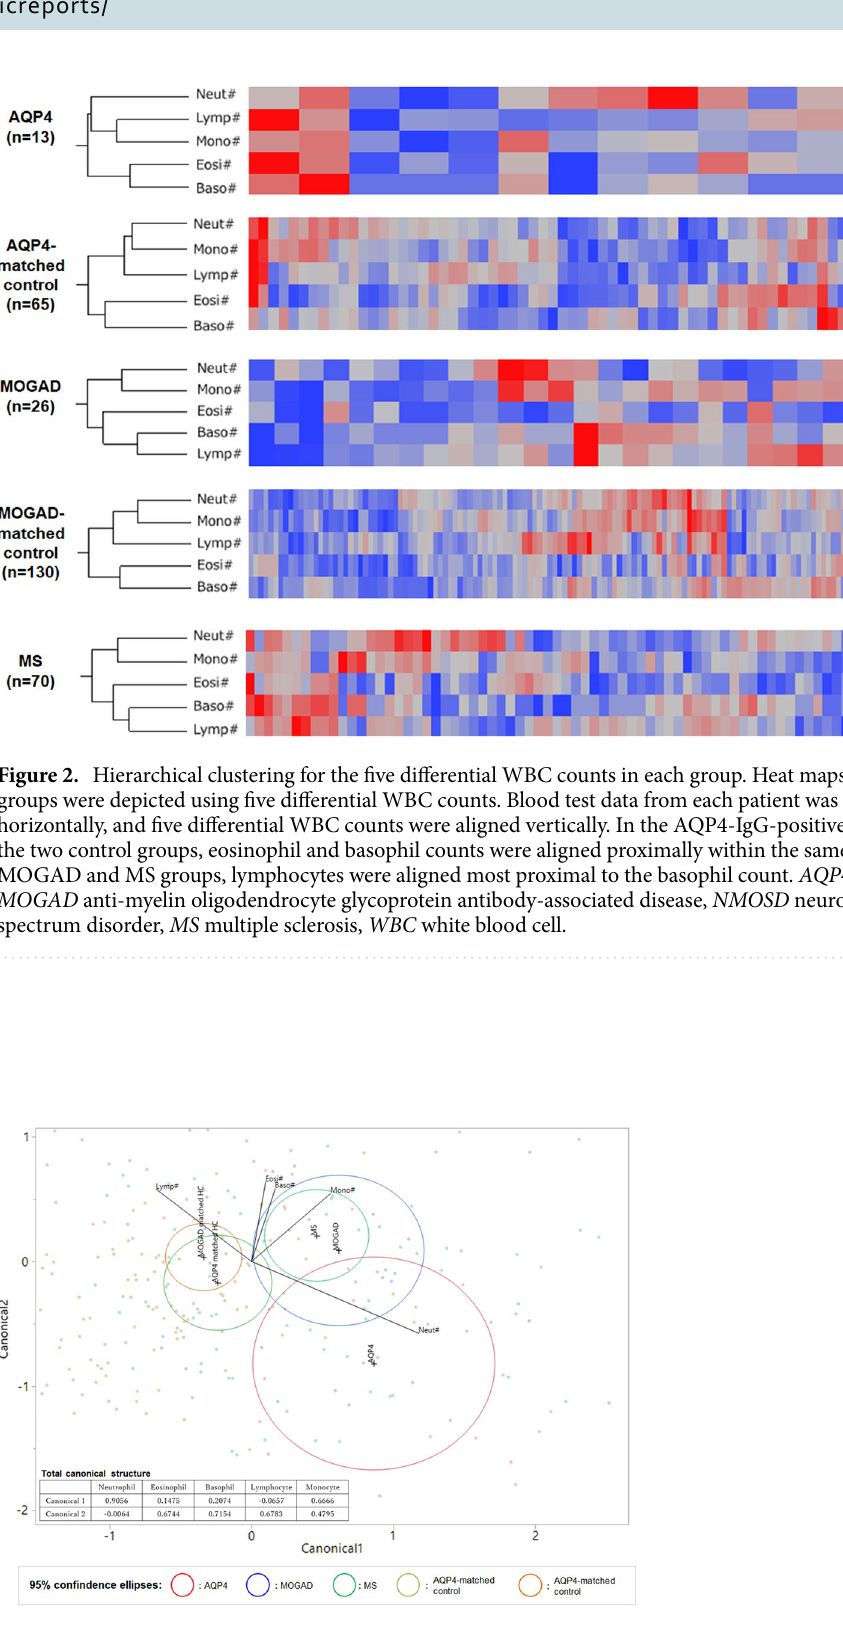
Figure 3. Two-dimensional canonical plots with the five differential white blood cell counts. In the two- dimensional canonical plot, 95% confidence ellipses for the means of the eight disease groups are shown. The ellipses for MOGAD and MS were located in approximately the same areas, whereas the ellipses for AQP4-IgG- positive NMOSD and the two matched controls were located away from them. AQP4 aquaporin-4, MOGAD anti-myelin oligodendrocyte glycoprotein antibody-associated disease, NMOSD neuromyelitis optica spectrum